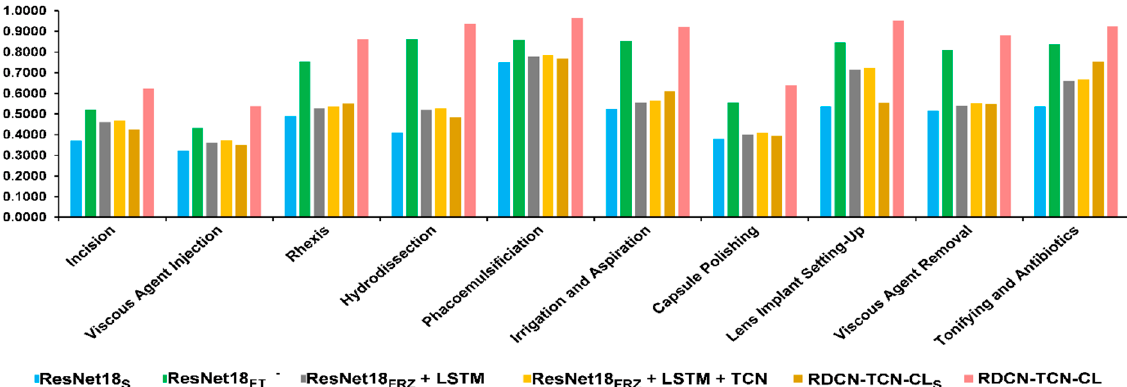
Figure 7. Class ‐ wise comparison of Surgical Actions 160 between RDCN ‐ TCN ‐ CL and other net ‐ work architectures, in the terms of retrieval performance (mAP averaged over 10 splits).